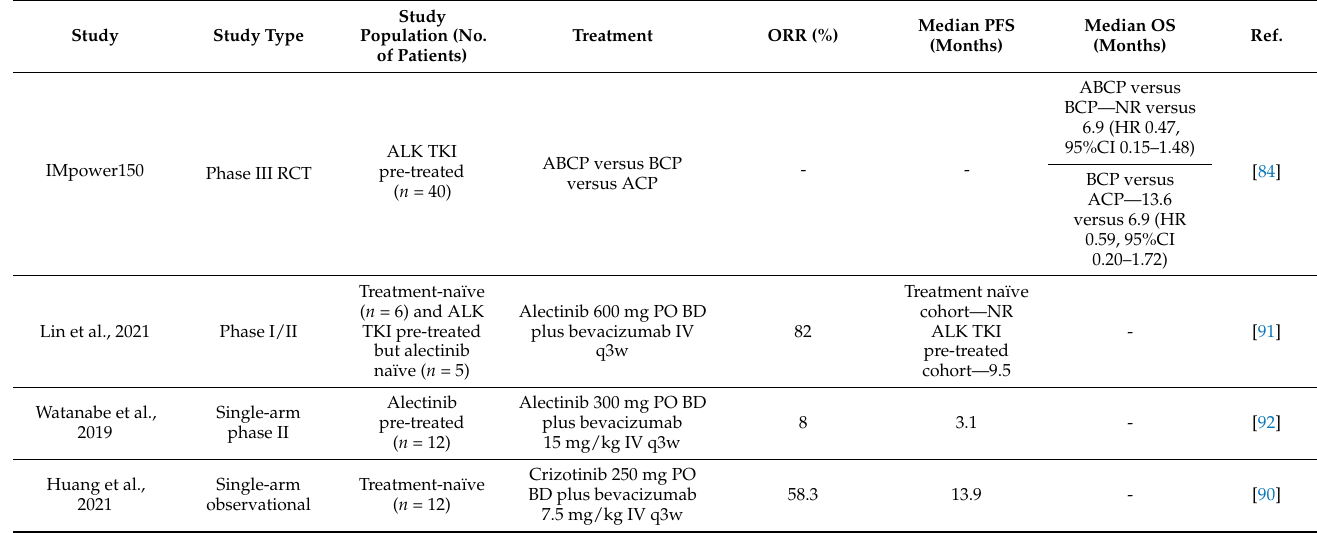
Table 1. Clinical trials evaluating anti-angiogenic therapy in ALK rearranged